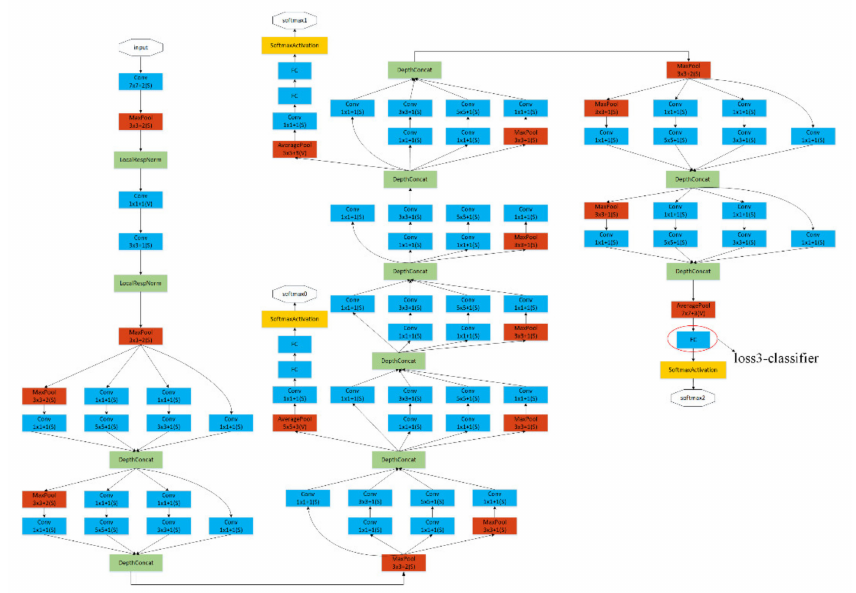
Figure 3. The architecture of GoogLeNet.